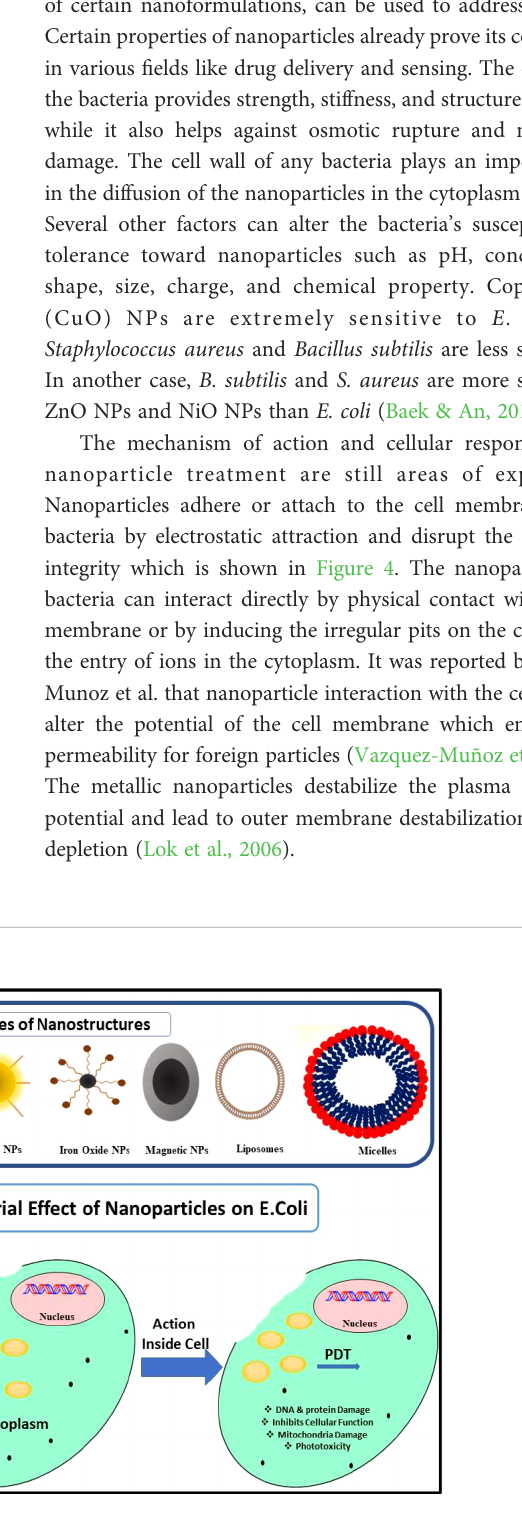
FIGURE 4 Schematic representation of the toxicology effect of nanoparticles on the bacterial